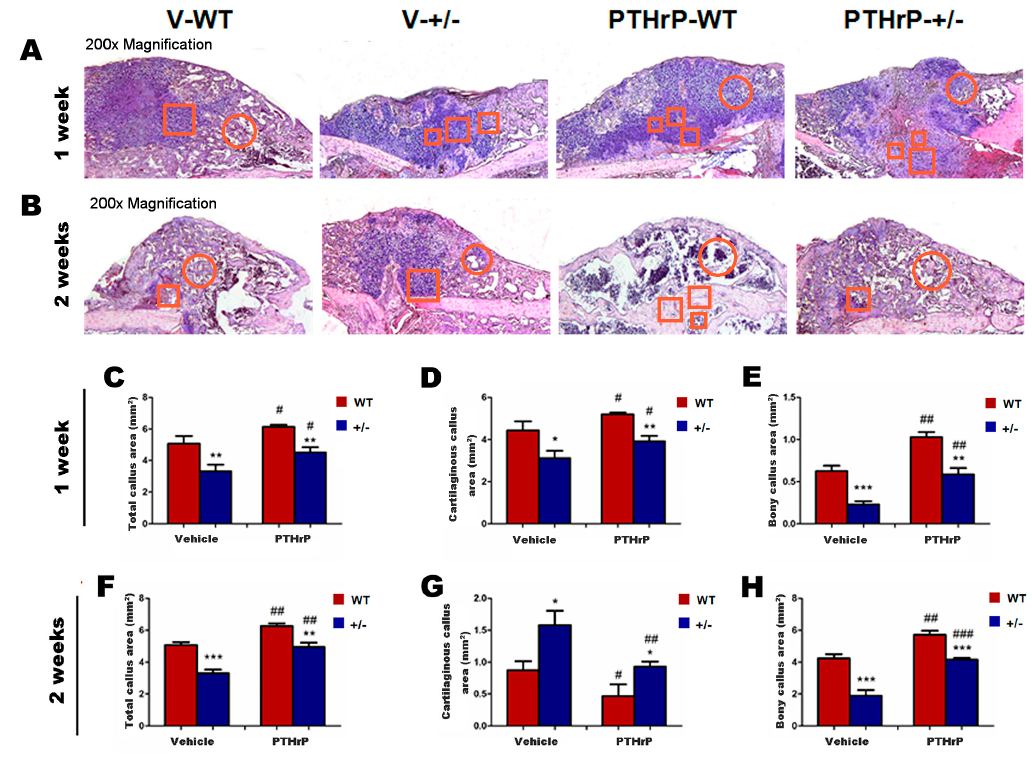
Figure 2. Effects of exogenous PTHrP on cartilaginous callus formation and on the